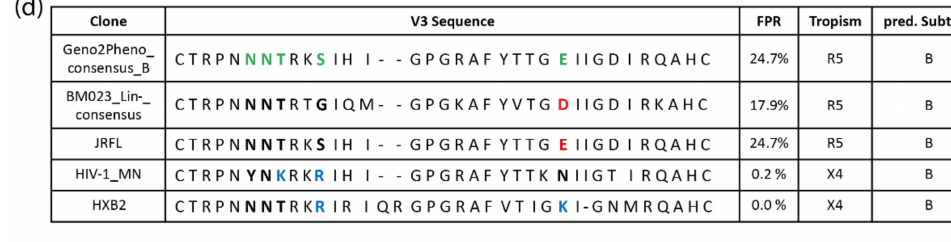
Figure 7. Screening for HIV-1 proviral DNA in hematopoietic progenitor cells from HIV-1-infected individuals. ( a ) Clinical data of screened donors. Units: age: age in years at bone marrow aspira- tion; time since diagnosis: years; viral load: RNA copies/mL; CD4: cells/ µ L; n.d.: not determined. ( b ) Detection of proviral HIV-1 DNA in sorted bone marrow-derived Lin + , Lin − , and CD34 + cells isolated from HIV-1-infected individuals using a nested PCR. Sensitivity of PCR: detection of one proviral genome in DNA of 10 5 non-infected cells in 66% of all cases. ( c ) Neighbor-joining phyloge- netic tree displaying env sequences (HIV region 6225-7817, HxB2 numbering), including the cluster of sequences isolated from hematopoietic Lin − cells from bone marrow sample BM023. Reference sequences were downloaded from the Los Alamos National Library database. For clade B, reference sequences from all major branches are shown. Reference sequences from HIV-1 group M clades other than B are collapsed to triangles for simplicity. Bootstrap values are indicated for branches of major interest (calculated with 500 bootstrap replicates). The bar indicates a genetic distance of 5%. ( d ) Geno2Pheno analysis and interpretation: Consensus HIV-1 Envelope V3 loop sequence isolated from BM023 Lin − cells compared to reference sequences and the consensus V3 loop sequence of HIV-1 clade B (Geno2Pheno; https://coreceptor.geno2pheno.org/index.php; accessed on 12 October 2021). Amino acids highlighted in green (consensus) are used to predict interaction with co-receptors; among these, negatively charged amino acids are highlighted in red in R5 sequences and positively charged amino acids are highlighted in blue in X4